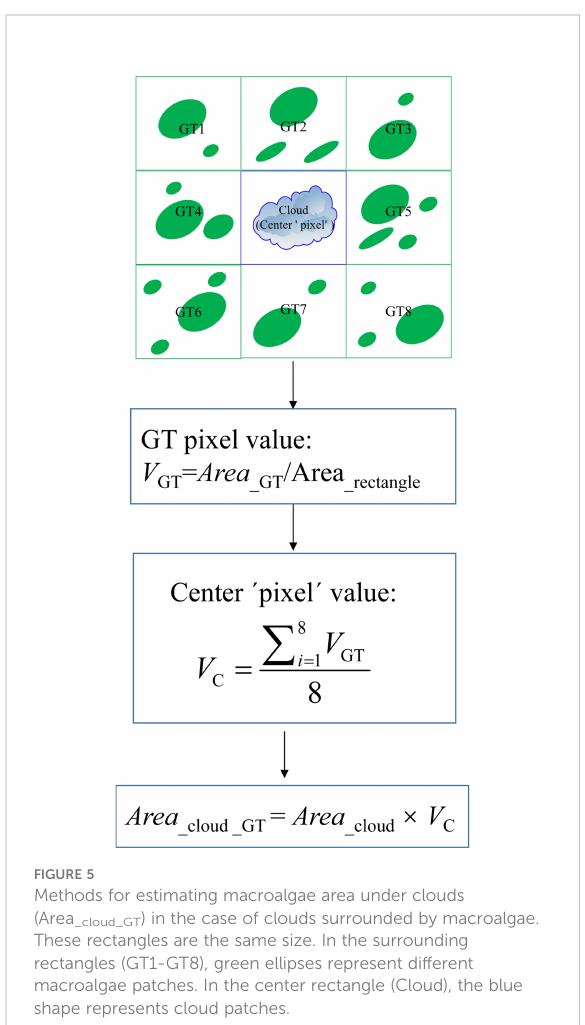
FIGURE 5 Methods for estimating macroalgae area under clouds (Area _cloud_GT ) in the case of clouds surrounded by macroalgae. These rectangles are the same size. In the surrounding rectangles (GT1-GT8), green ellipses represent different macroalgae patches. In the center rectangle (Cloud), the blue shape represents cloud